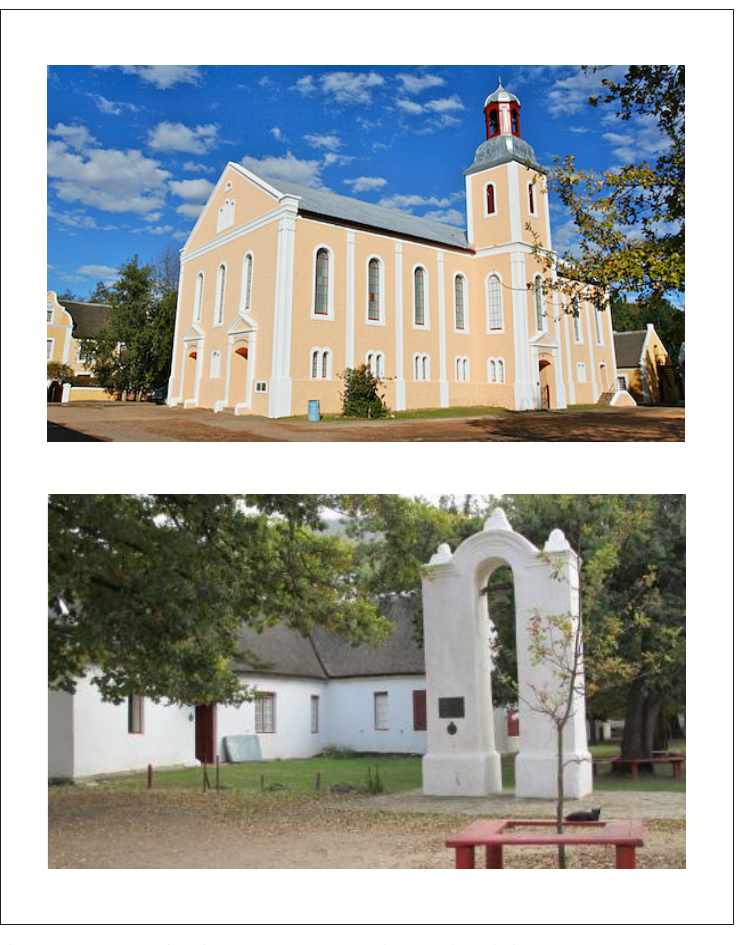
Figure 4: Photos of heritage earth-construction public building on Church Square in